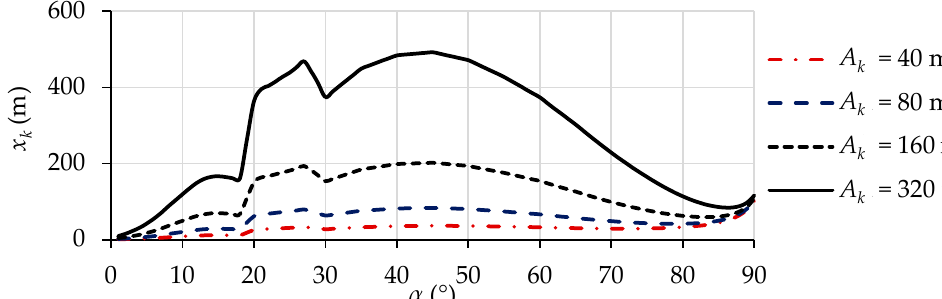
Figure 8. The kite horizontal coordinates for each kite area and angle of attack at a ship speed of 7.27 m/s and a reference wind speed of 20 m/s.